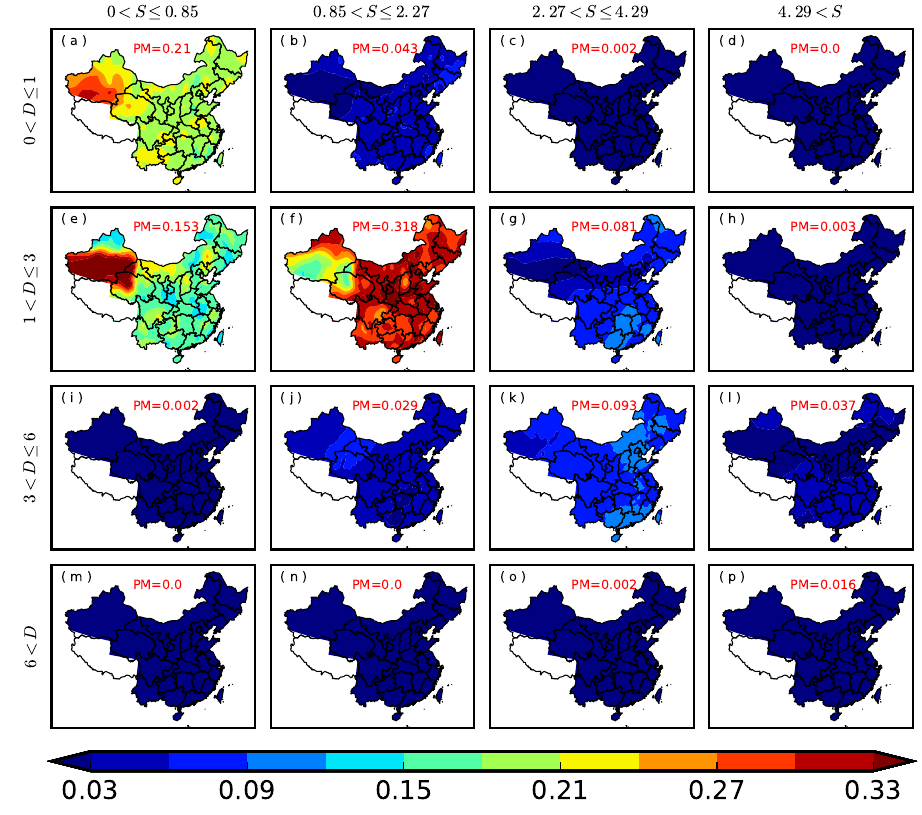
Figure 9. Interval probability based on the semiempirical method: ( a – p ) represent different drought